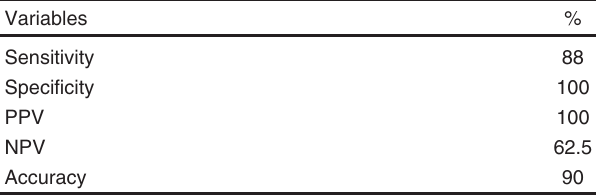
Table 6 Diagnostic yield of ultrasound-guided needle biopsy